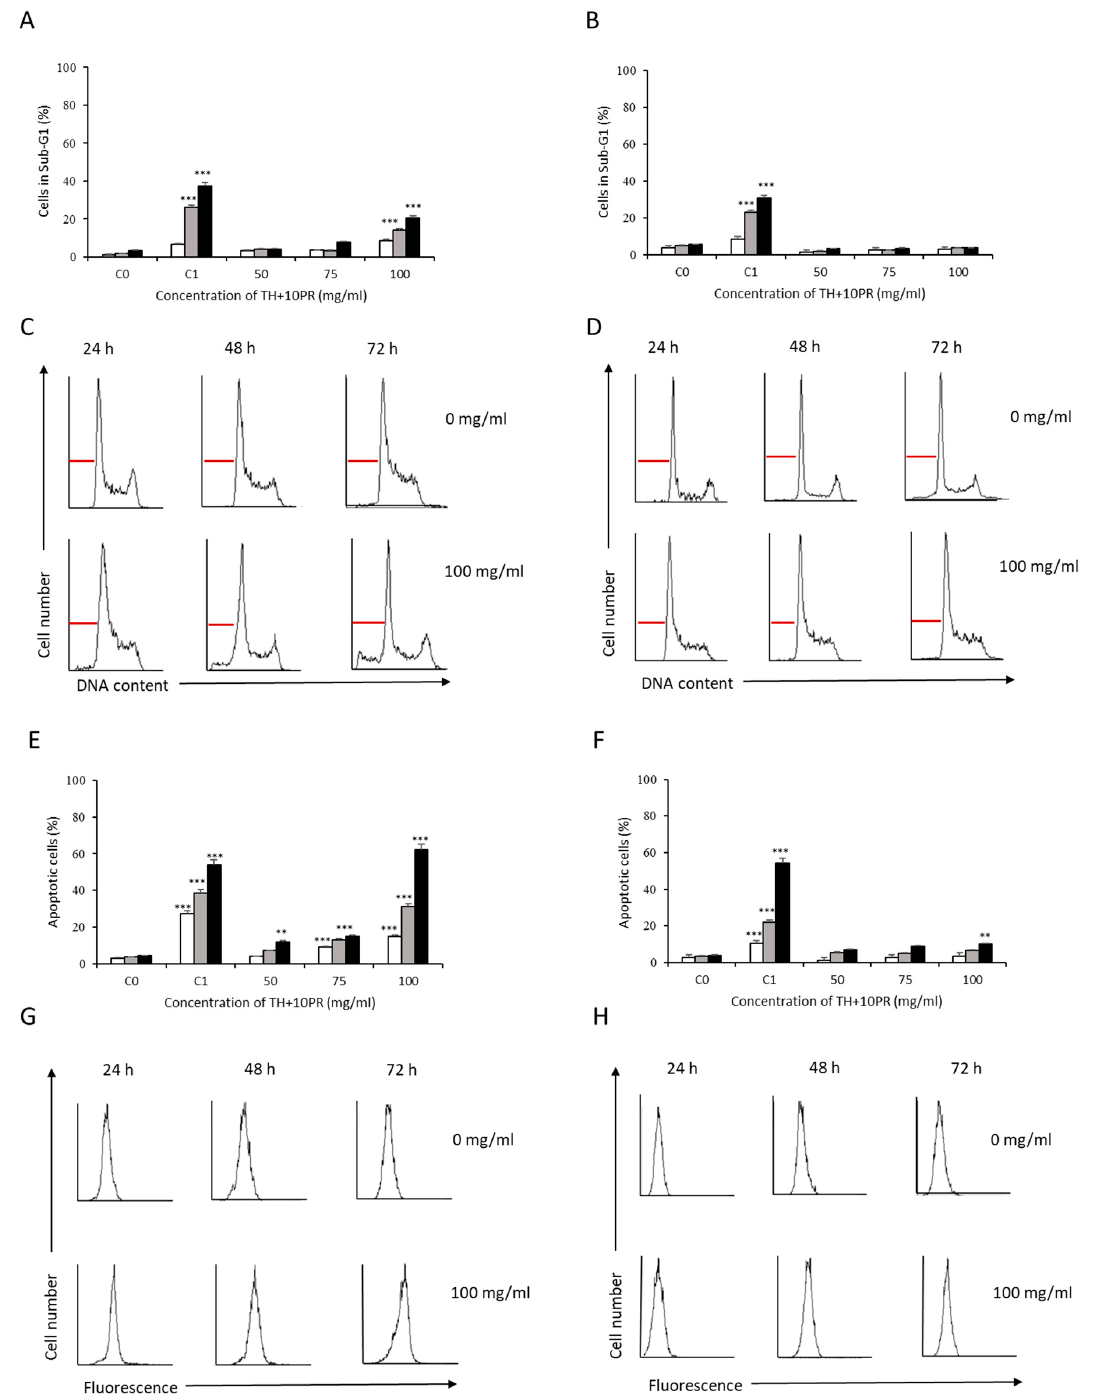
Figure 8. Effect of sample 5 (TH+10PR) on human liver cell apoptosis. The cell cycle was determined using flow cytometry. HepG2 ( A ) and WRL-68 ( B ) cells were treated with different doses of sample 5 (50, 75, and 100 mg/mL) for 24 ( □ ), 48 ( ■ ), and 72 h ( ■ ). Representative histograms of the cell cycle of HepG2 ( C ) and WRL-68 ( D ) cells are shown; the red line indicates the sub-G1 phase. The percentage of apoptosis was analyzed by flow cytometry using the TUNEL assay. HepG2 ( E ) and WRL-68 ( F ) cells were cultured with different doses of sample 5 (50, 75, and 100 mg/mL) for 24 ( □ ), 48 ( ■ ), and 72 h ( ■ ). Representative histograms of the fluorescence intensity in HepG2 ( G ) and WRL-68 ( H ) cells are presented. C 0 , untreated cells; C 1 , cells treated with etoposide (50 µM). Asterisks indicate a significant difference from the control (C 0 ). ** p ≤ 0.01,*** p ≤ 0.001.